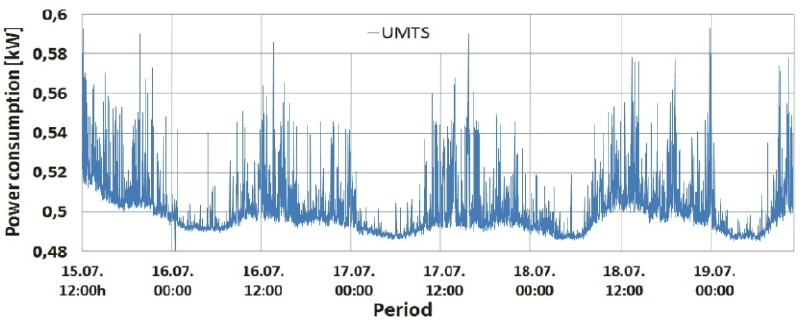
Figure 7. Power consumption of UMTS BS